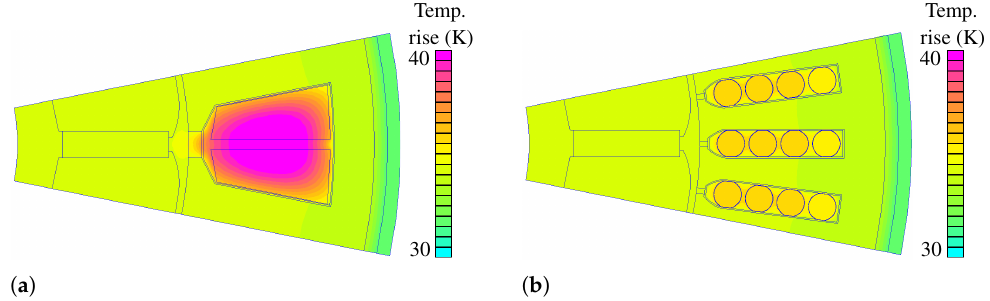
Figure 28. IPM spoke heat analysis with different stator windings. ( a ) Non-overlapped coil windings. ( b ) Hairpin